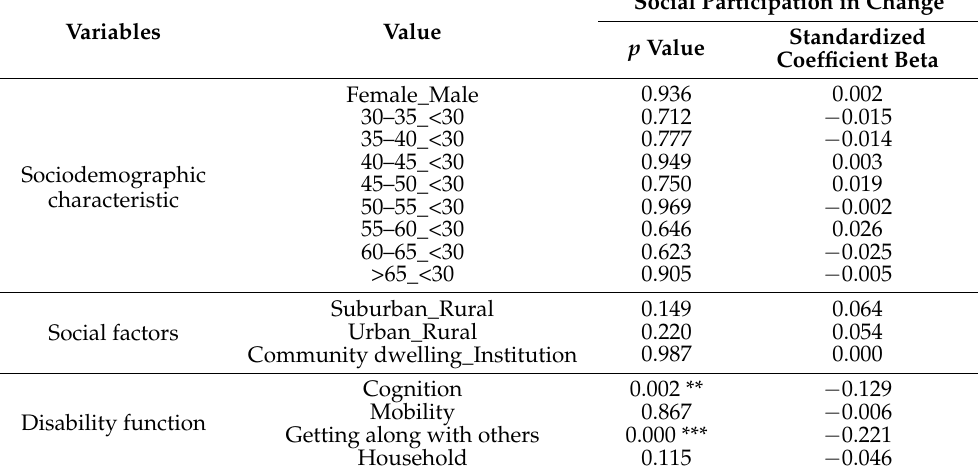
Table 4. Results from regression analysis showing factors influencing changes in participation using sociodemographic characteristics (age and gender), social factors (urbanization level and residence type), and disability function (cognition, mobility, getting along with others, and household activities). Variables Value